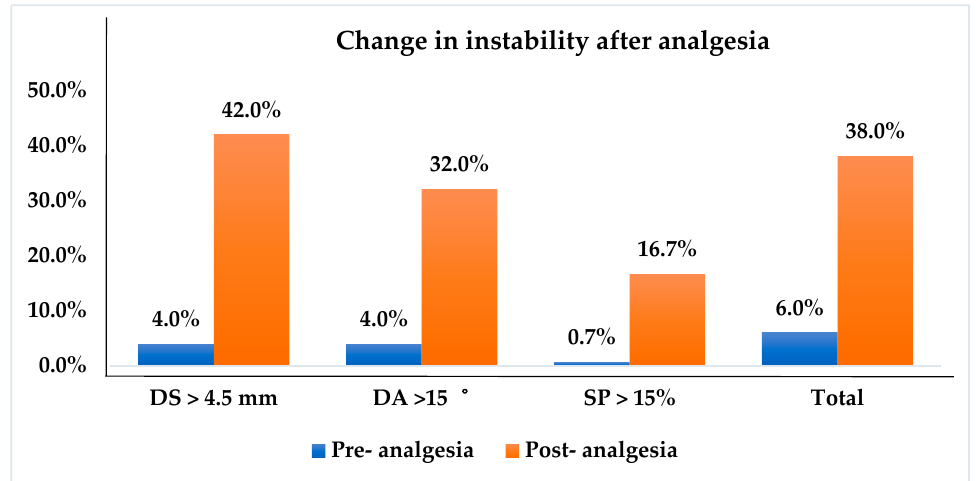
Figure 3. The changes in radiographic instability after analgesia. This figure shows the change in frequency in the segmental instability before and after the analgesia. There were a total of 150 motion segments. According to the diagnostic criteria for segmental instability (DS > 4.5mm, DA > 15°, or SP > 15%), there was 4% (6), 4% (6), and 0.7% (1), respectively, of total motion segment fulfilling the diagnostic criteria. After analgesia, the diagnostic instability markedly increased to 42% (63), 32% (48), and 16.7% (25). In 100 patients, the number of potentially diagnosed cases of instability was increased from 6 (6%) before analgesia to 38 (38%) after analgesia.